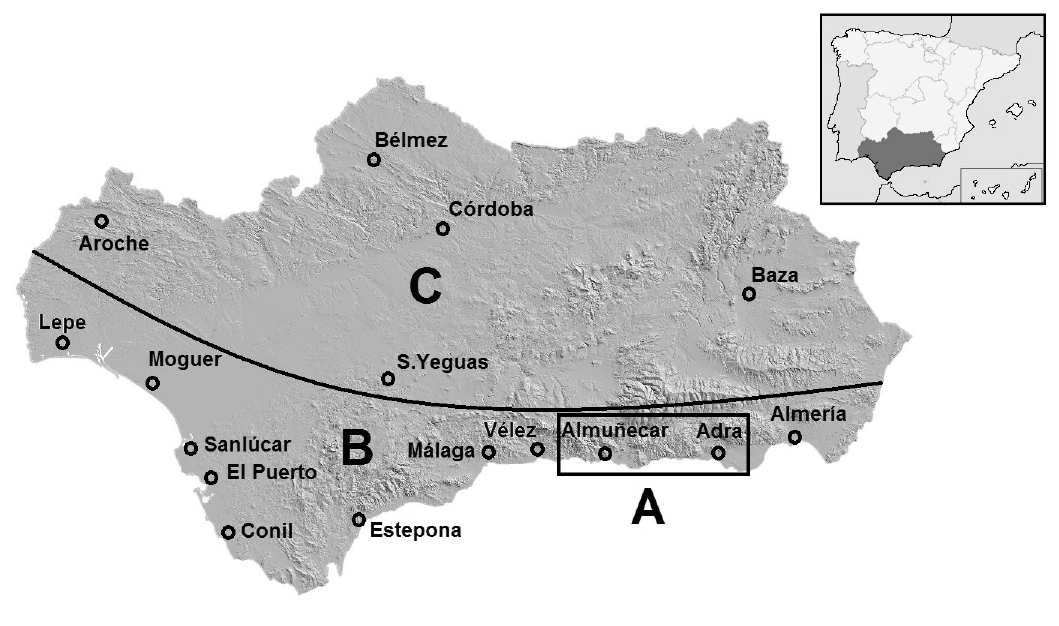
Figure A6. Distribution of the three areas described in Figure A4. A and B areas are in the coastline and C in the